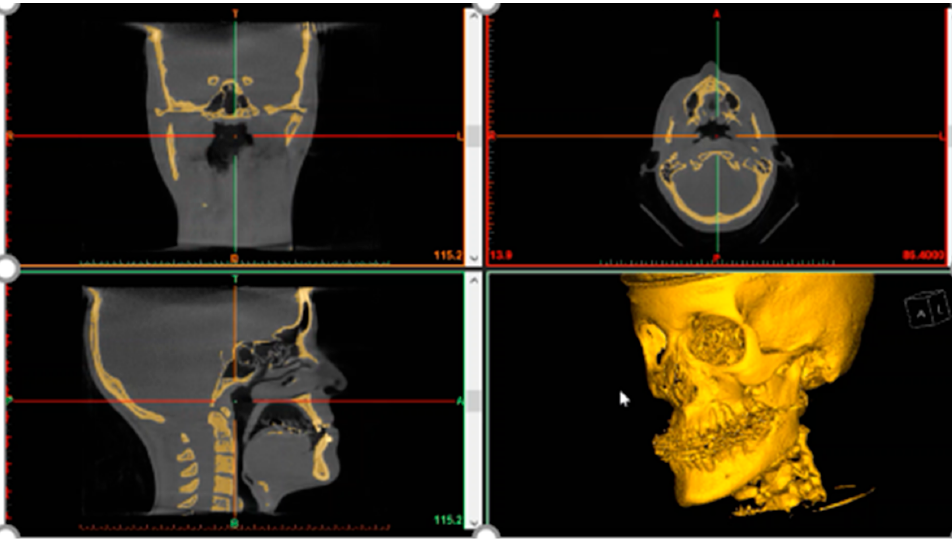
Figure 3. Anatomical segmentation and volumetric data extraction. Mimics 3D evaluation used to delineate threshold bone regions of interest (ROIs).